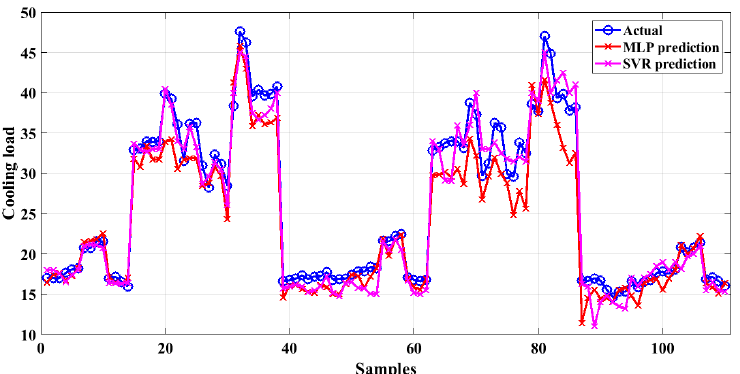
Figure 7. Heating load forecasting via MLP and SVR.